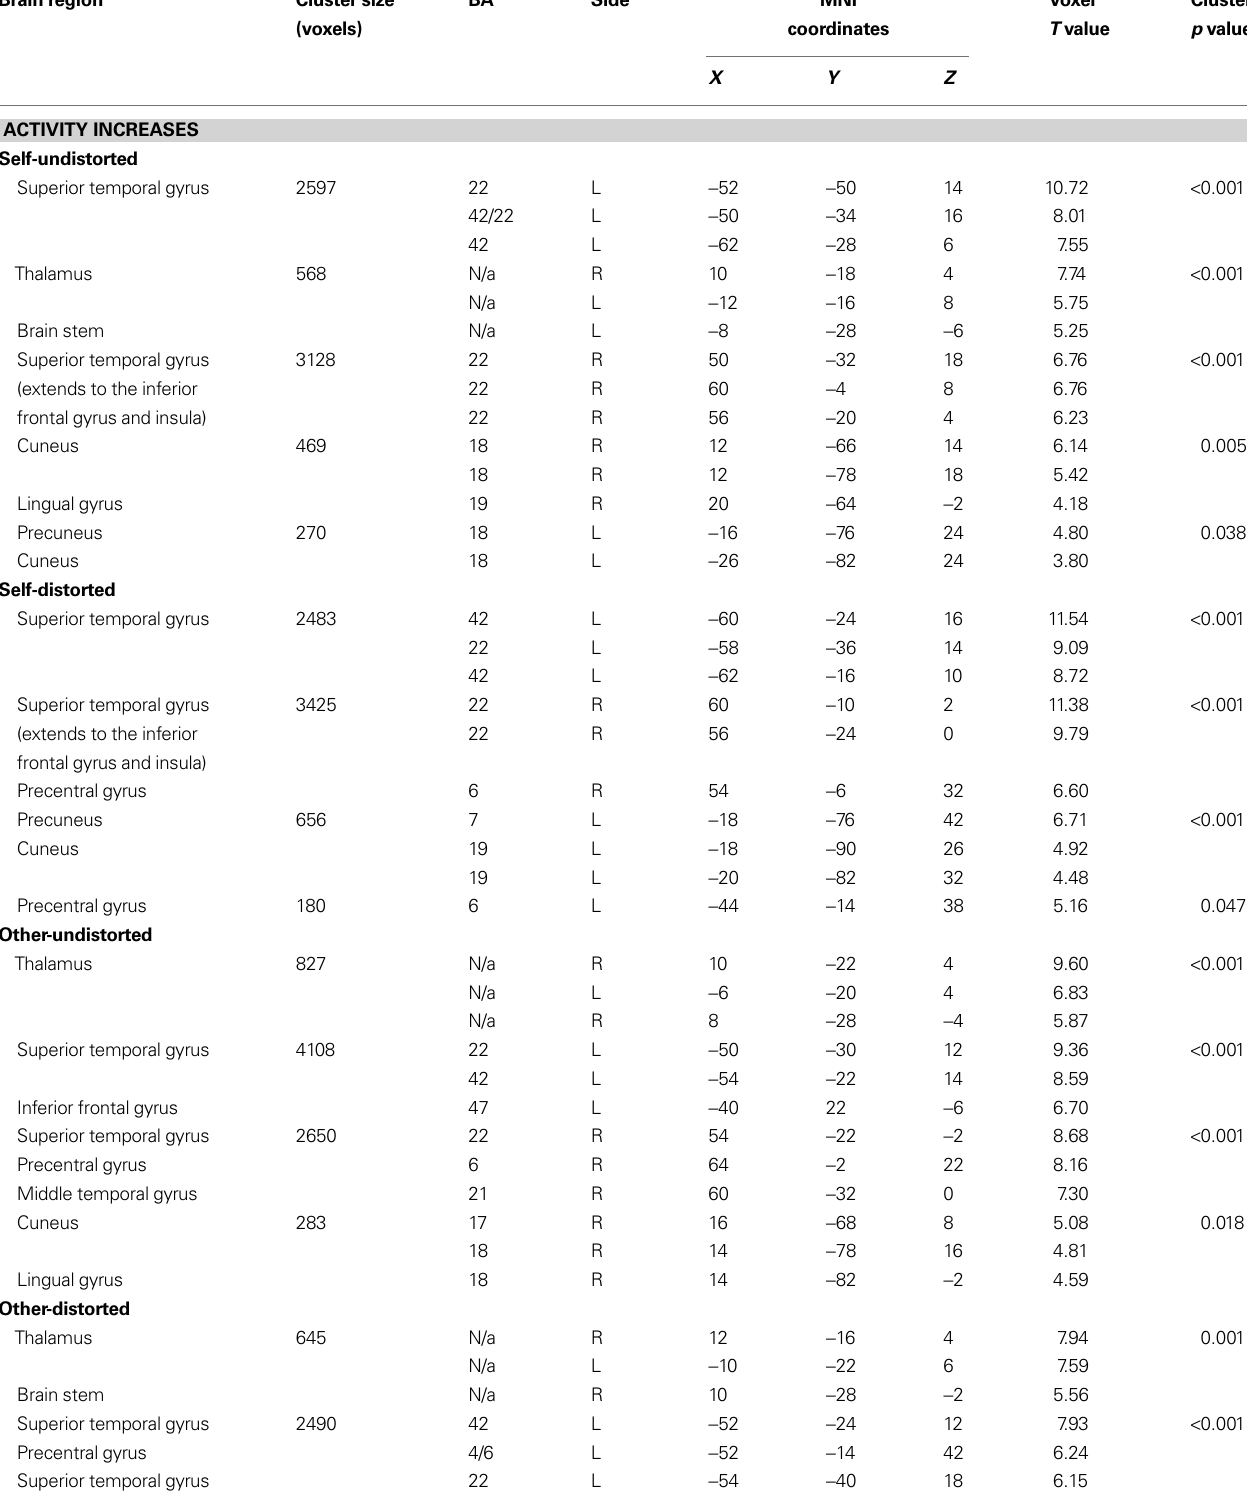
Table 3 | Brain areas showing signifi cant change in task-related activity in CBTp + TAU patients (voxel threshold p = 0.001; cluster p corrected for multiple